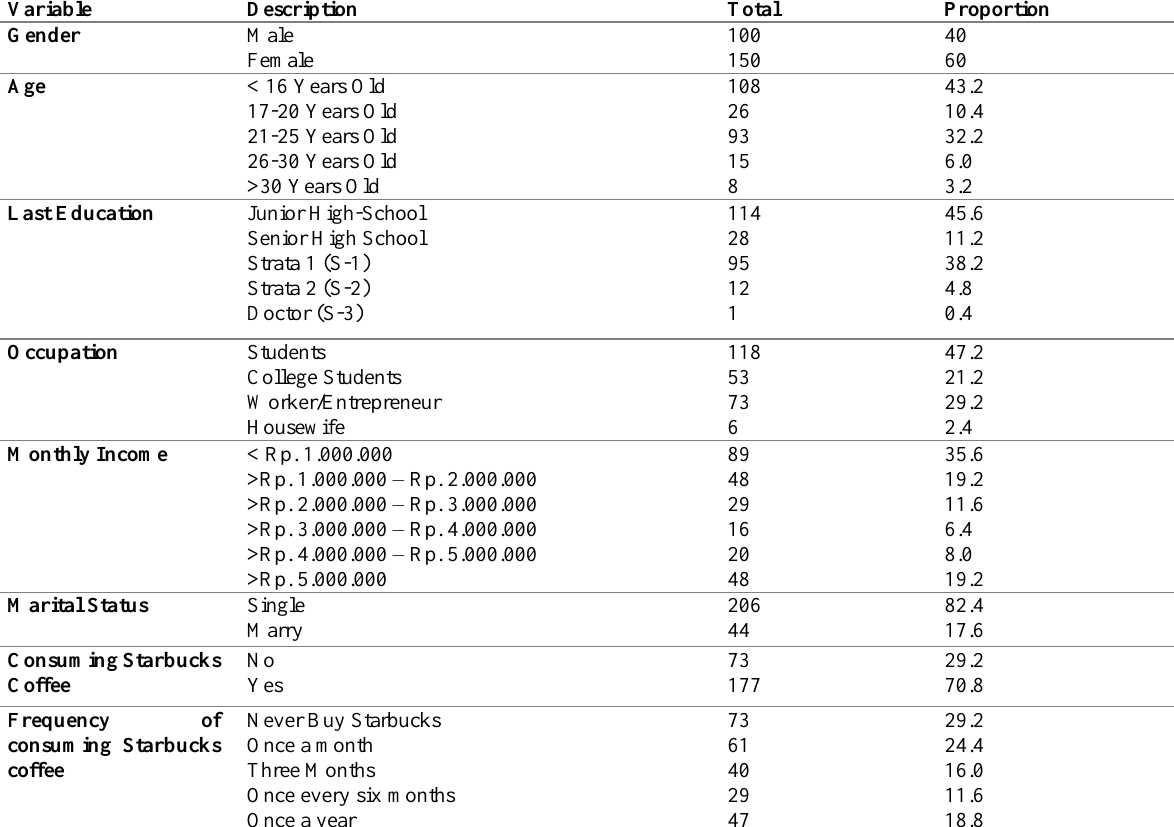
Table 1: Demographic of the